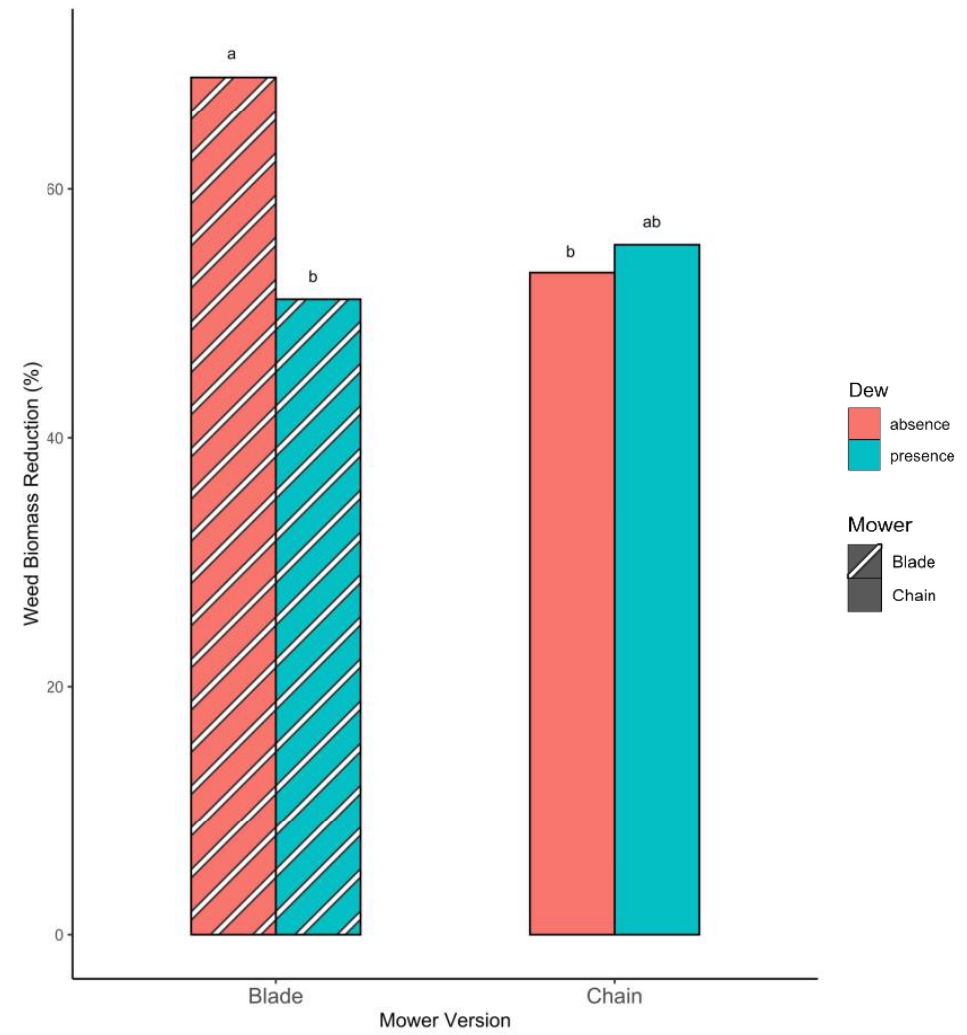
Figure 12. Effect of the interaction between mower version and dew condition on weed biomass reduction. Means denoted by different letters are significantly different at p < 0.05 (LSD test).